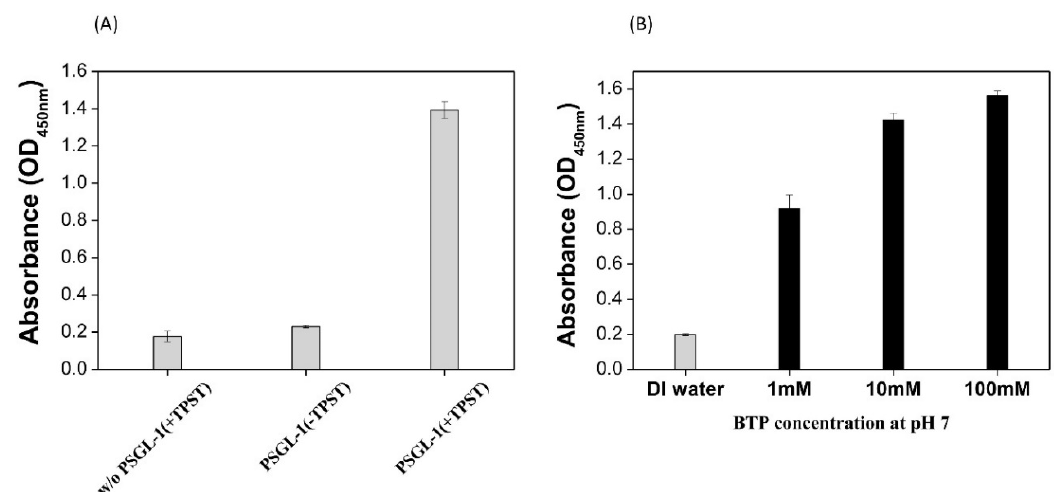
Figure 3. In situ determination of PTS by ELISA ( A ) PSGL-1 peptide was coated on the surface of the 96-well plate and subsequently blocked with milk. The immobilized PSGL-1 was treated with PST–TPST assay to produce protein sulfation. Control experiment was performed in the absence of the critical enzyme TPST, and the PTS reaction through PST–TPST enzyme without the substrate peptide, PSGL-1. Anti-sulfotyrosine antibody and horseradish peroxidase (HRP)-conjugated secondary antibody were used to determine PTS reaction on PSGL-1, as expected. The average value was obtained from three independent measurements. ( B ) ELISA absorbance value plotted vs. varying concentrations of antibody incubation buffer, bis-tris propane (BTP).